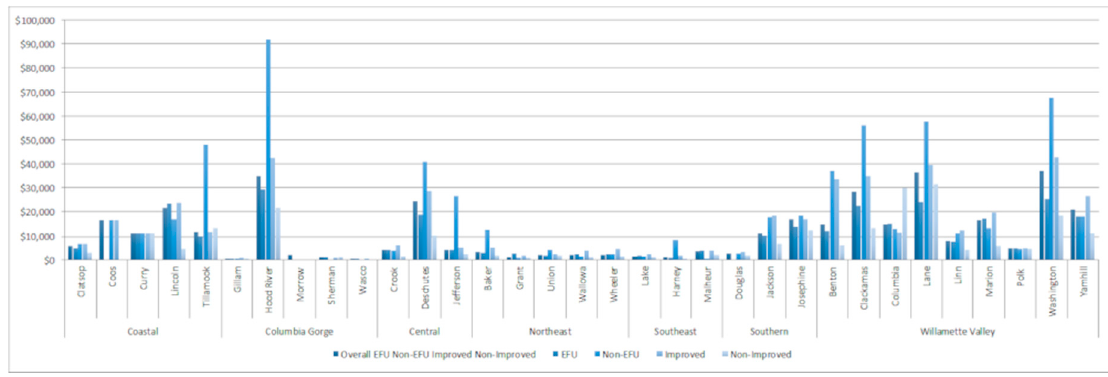
Figure 4. Price per acre by farmland type, county, and